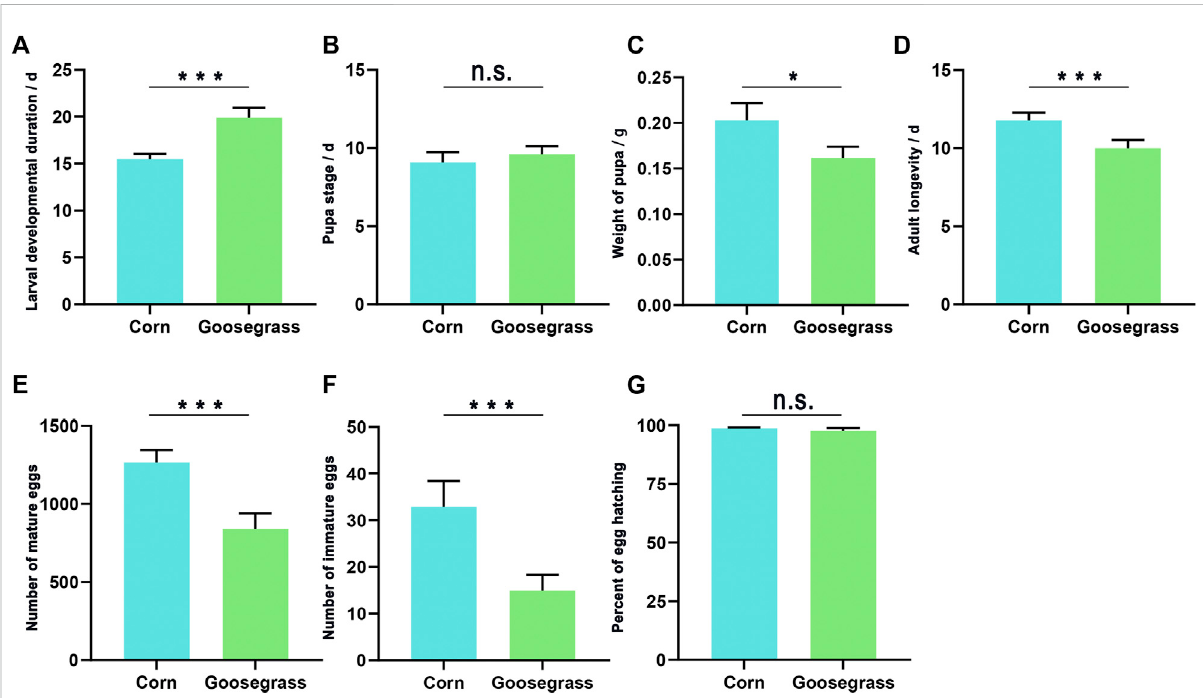
FIGURE 1 Biological parameters of S. frugiperda fed on corn and goosegrass. (A) Larval developmental duration. (B) Pupal stage. (C) Weight of the pupa. (D) Adult longevity. (E) Number of mature eggs. (F) Number of immature eggs. (G) Percent of egg hatched. Asterisks indicate signi fi cant differences between hosts (*, p < 0.05; **, p < 0.01, ***, and p <